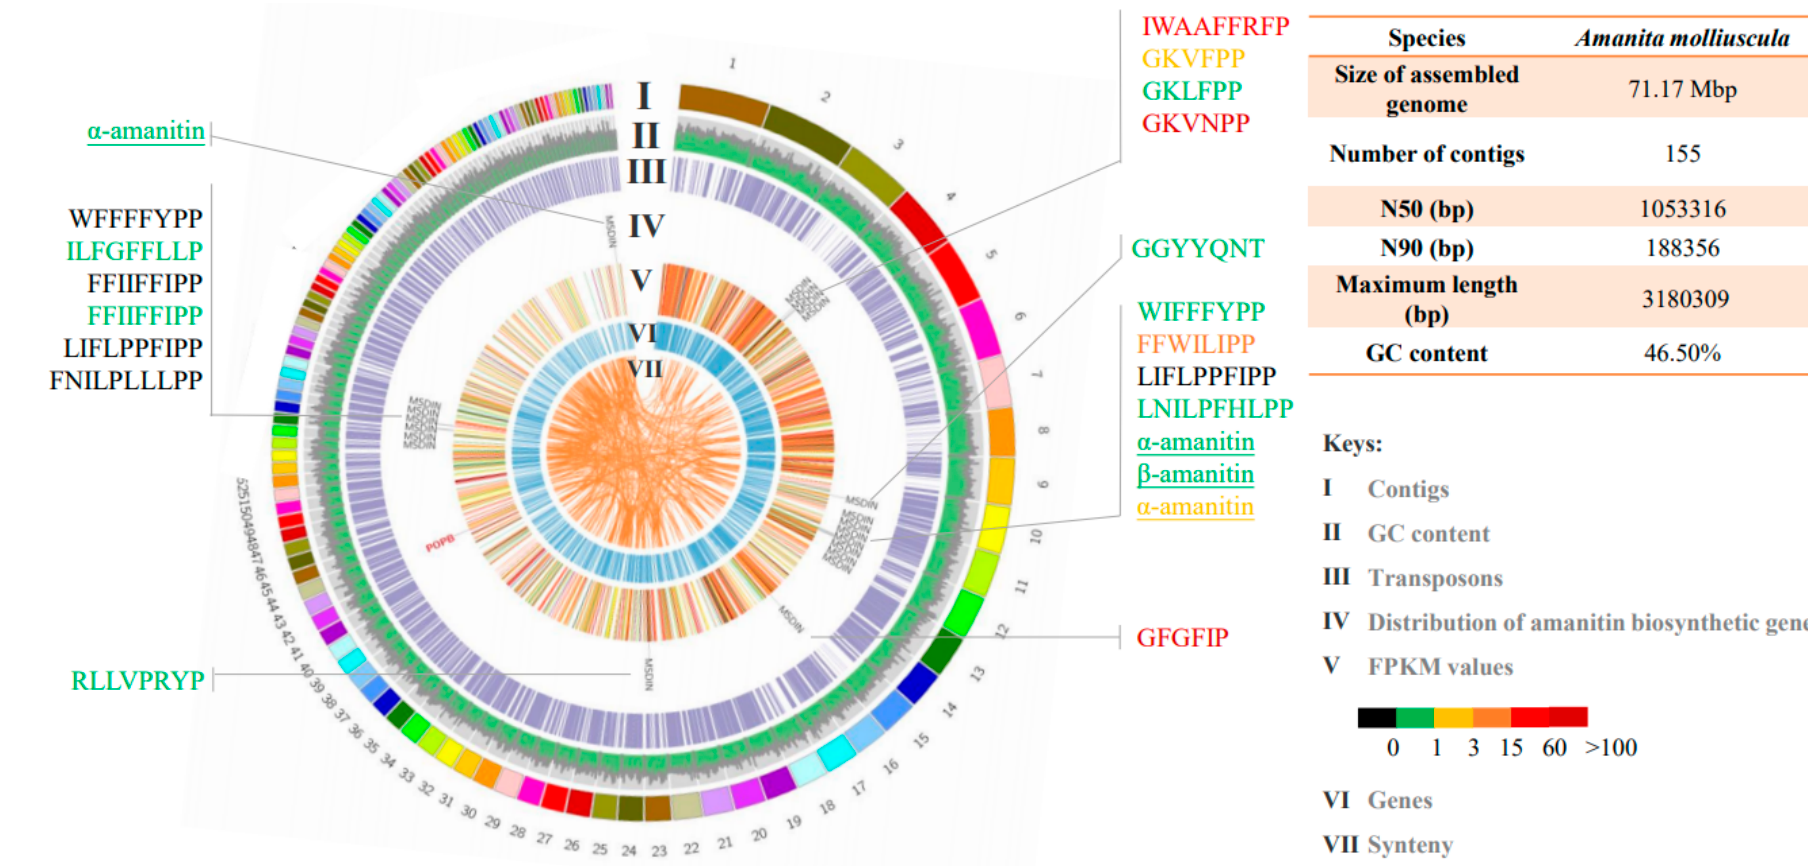
Figure 2. Genome of Amanita molliuscula and transcription of the amanitin biosynthetic genes. Tracks: I , Contigs; II , GC content; III , Transposons; IV , Distribution of amanitin biosynthetic genes; V , FPKM values of genes; VI , Distribution of genes; VII , Synteny. Statistics of the genome is shown on the upper right. Amanitin biosynthetic genes are shown in Track IV , with expression levels of MSDIN genes shown surrounding the genome circle (keys on the lower right).